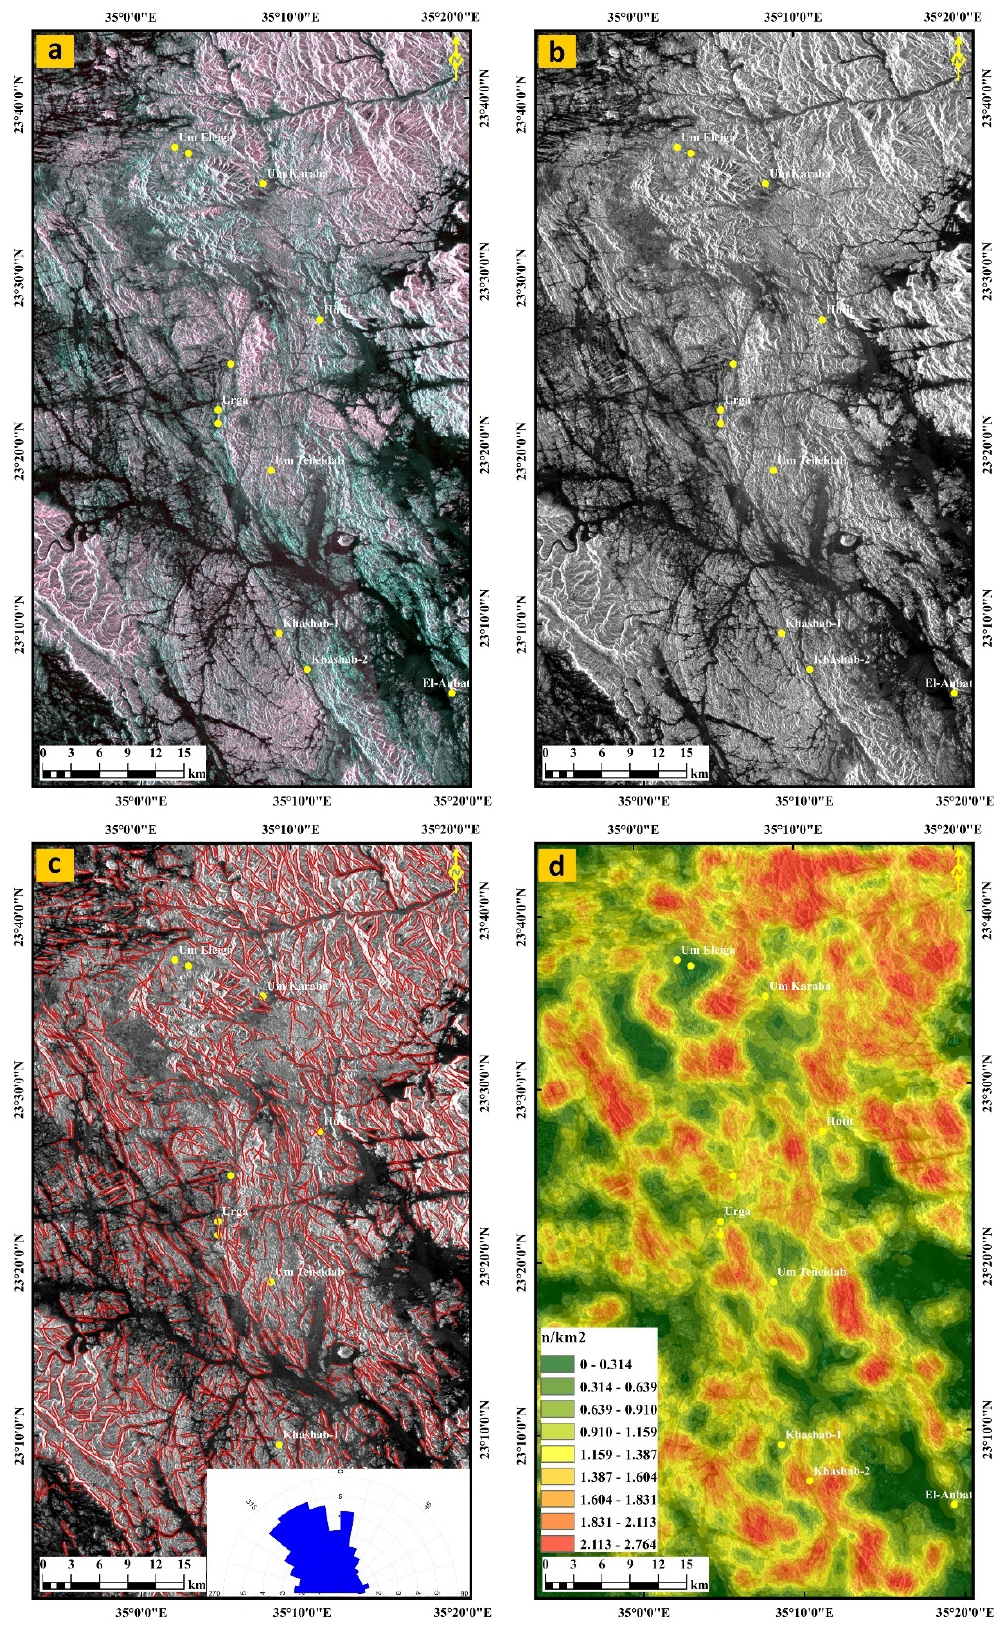
Figure 7. Lineaments extraction using processed PALSAR data ( a ) PCA of enhanced Lee filter of HH, HV, HH + HV in RGB-PC1, PC2, PC3, ( b ) PC1 highlights lineaments features, ( c ) the extracted lineaments dropped over PC1 with inset azimuth-frequency diagram and ( d ) lineament density map.